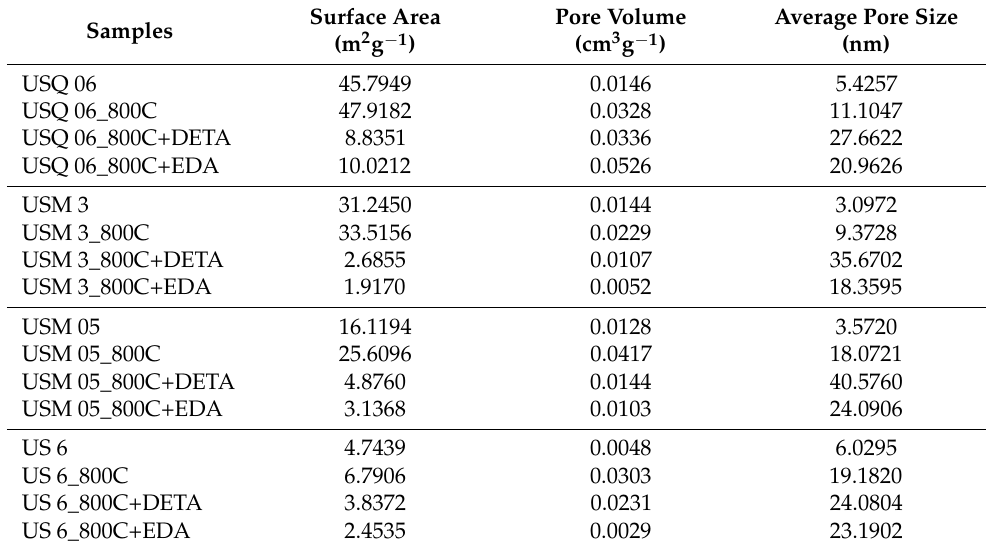
Table 2. Variation in the pore classification after pyrolysis and amine modification